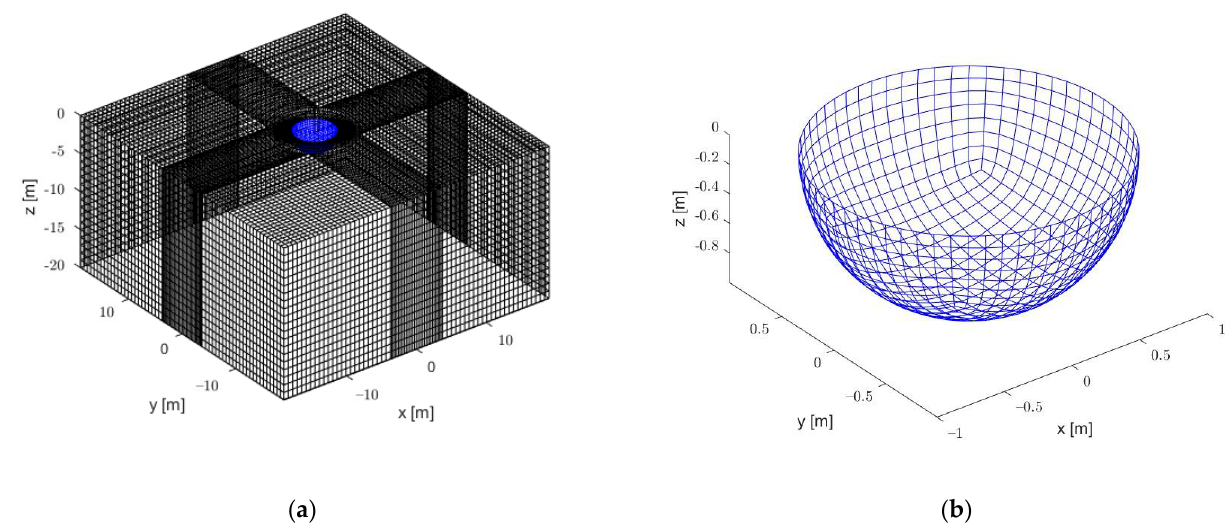
Figure 2. Mesh system of 3F-FR-NWT: ( a ) full domain; ( b ) body mesh.